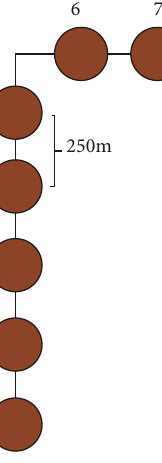
Figure 2: The NAFORMA cluster and plot design